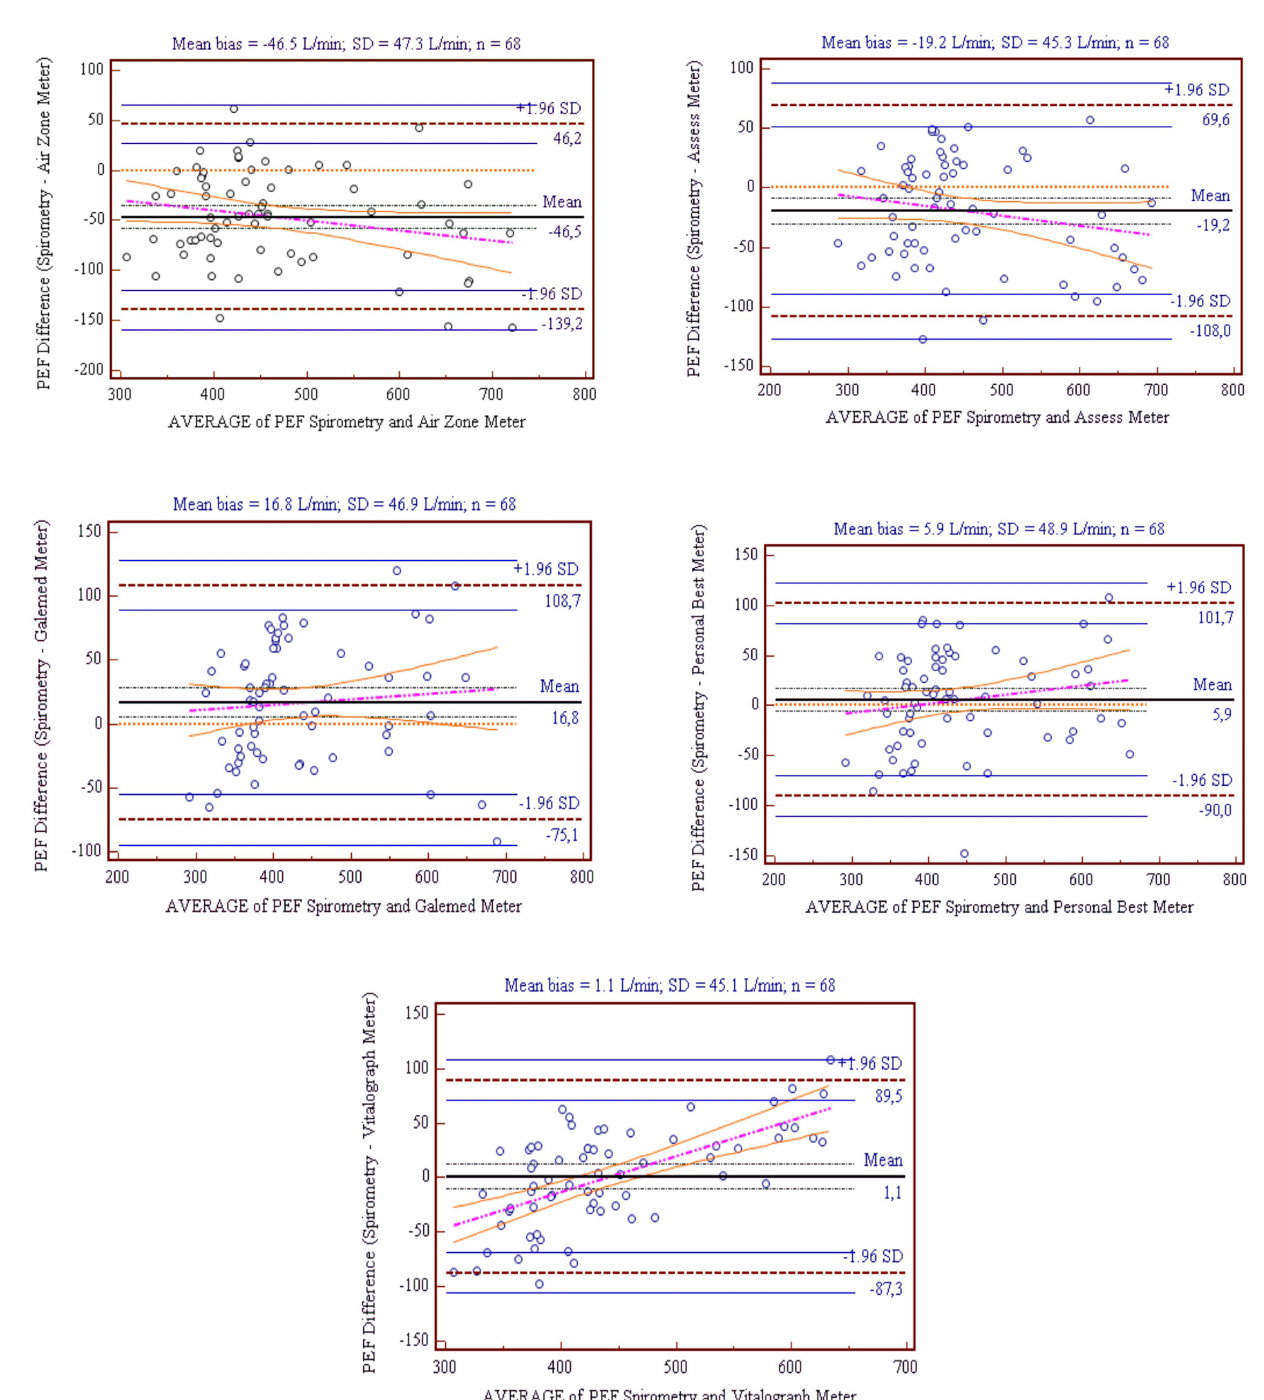
Figure 2 - Agreement rate between PEF spirometric values and those of the Air Zone® meter (A); the Assess® meter (B); the Galemed® meter (C); the Personal Best® meter (D); and the Vitalograph® meter (E) according to a Bland-Altman analysis. PEF = peak expiratory flow; Bias = mean of the differ- ences among the averages; SD = standard deviation; n = number of subjects; ± 1.96SD= 95% of confidence interval (CI). Orange line = regression line of differences versus averages; blue line= 95% CI of limits of agreement; brown dashed line= 95% CI mean of Personal Best® (figure 2D) and Vitalograph® (figure 2E) 89.5L/min). A great variation in the limits of agreement was were, respectively, -46.5±47.3 (-139.2 to 46.2L/min), observed, i.e., around 185.4 L/min for Air Zone®, 177.6 L/ -19.2±45.3 (-108.0 to 69.6L/min), 16.8±46.9 (-75.1 to 108.7L/ min for Assess®, 183.8 L/min for Galemed®, 191.7 L/min for min), 5.9±48.9 (-90.0 to 101.7L/min) and 1.1±45.1 (-87.3 to Personal Best® and 176.8 L/min for Vitalograph®.